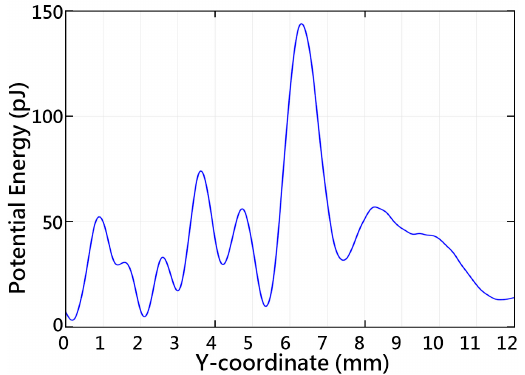
Figure 6. Simulated acoustic potential energy along the central axis of the acoustic tweezers.